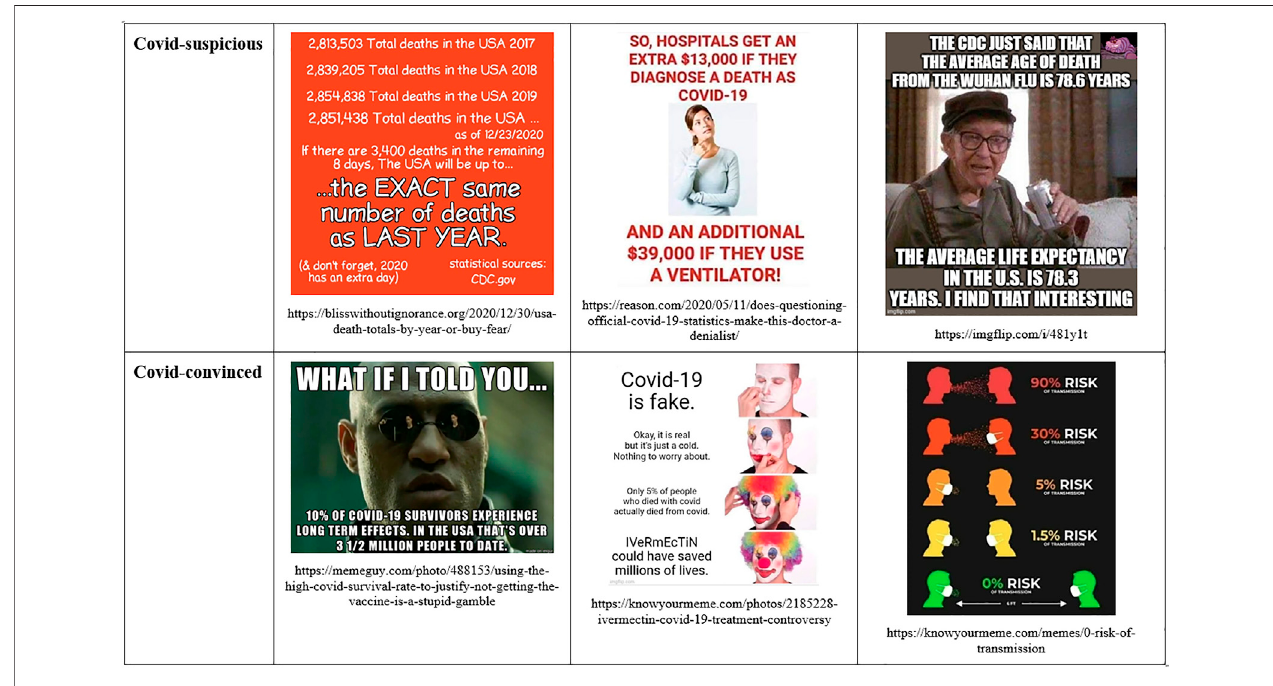
FIGURE 5 | Number work in Covid-suspicious and Covid-convinced memes.